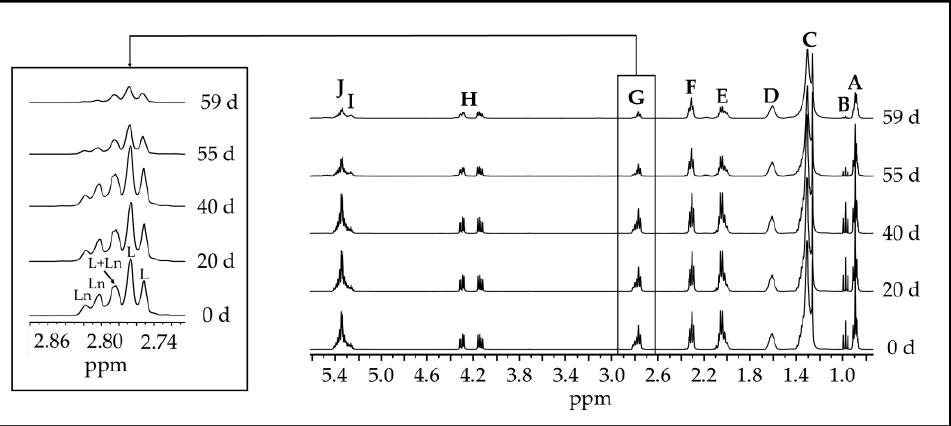
Figure 1. 1 H NMR spectra of the walnut oil (W) at different days (d) of its accelerated storage at 40 ◦ C, and the enlargement of signal G due to the bis-allylic methylene protons of their linoleic and linolenic acyl groups. As can be observed in this figure, the intensity of some of the walnut oil spectral signals (signal assignments in Table S1) decreases through time due to the degradation of the most unsaturated acyl groups. Indeed, some of them had almost disappeared at the most advanced stage of the oxidation process. This behaviour is also observed, in general terms, in the spectra of the other samples submitted either at 40 ◦ C or at 70 ◦ C. However, both factors, the α T enrichment degree and storage temperature, have an important influence on the evolution of the polyunsaturated acyl group concentration in this